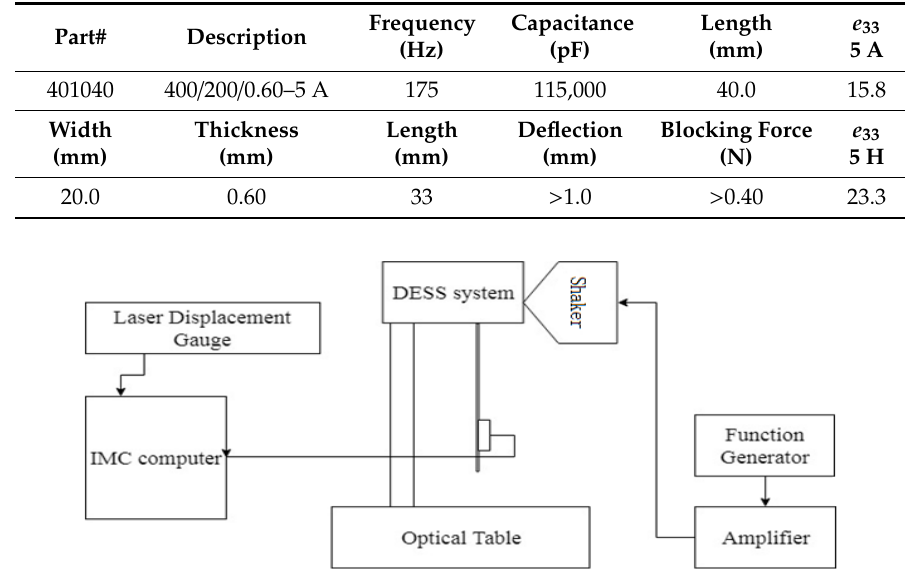
Table 1. Piezo patch specifications.